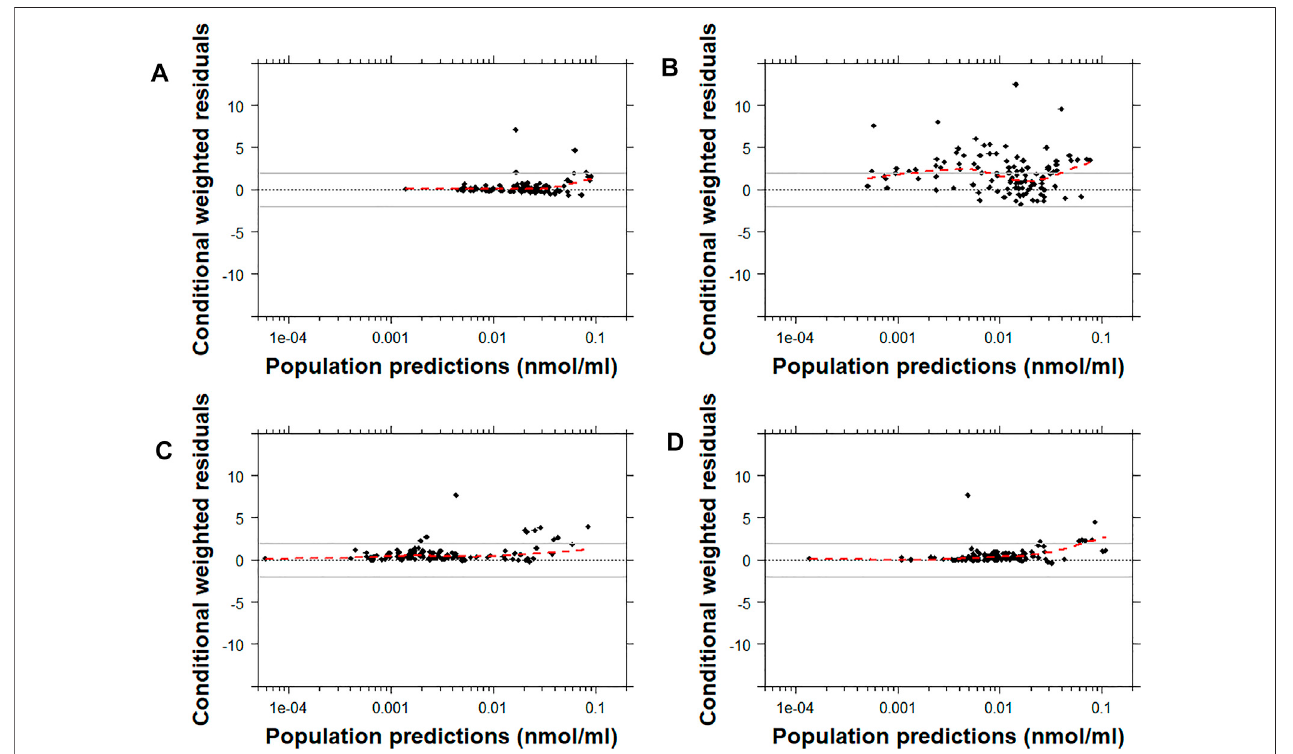
FIGURE5| Conditionalweightedresidualsversuspopulationspredictions for9-OH risperidone plottedon alogscale. Model (A) :Kloosterboer et al.,2021;Model (B) : Sherwin et al., 2012; Model (C) : Feng et al., 2008; and Model (D) : Feng et al., 2008 with allometric scaling. The dashed black line corresponds to a CWRES of zero. The solid grey lines correspond to CWRES values of 2 and -2. The dashed red line corresponds to the locally-weighted scatterplot smoothing curve (LOWESS).